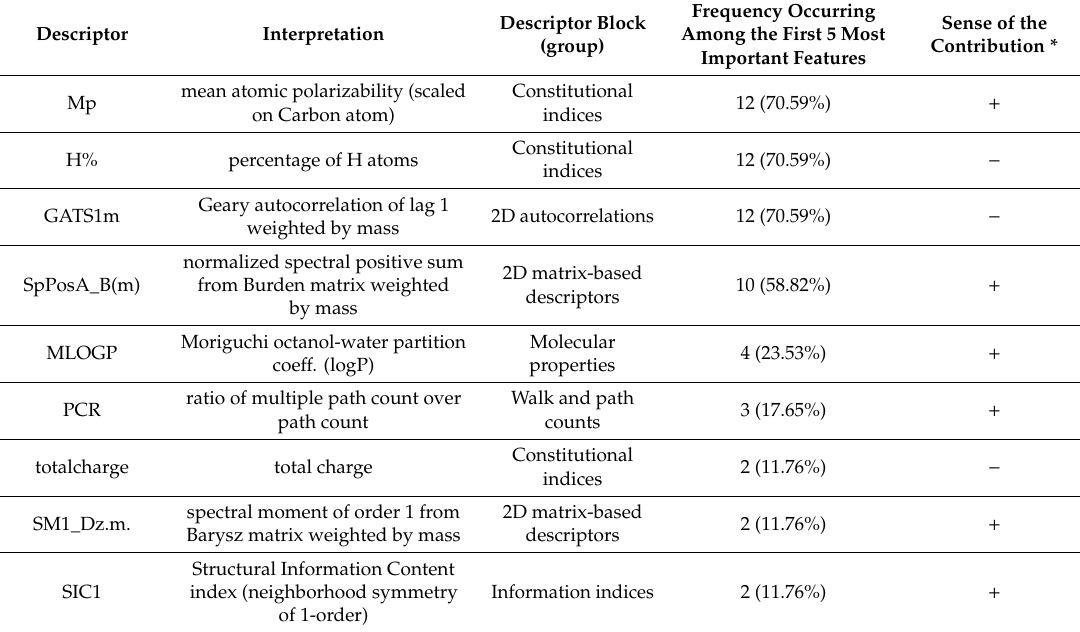
Table 1. The most important molecular descriptors associated with drug-induced liver injury (DILI) by the 17 feature selection algorithms